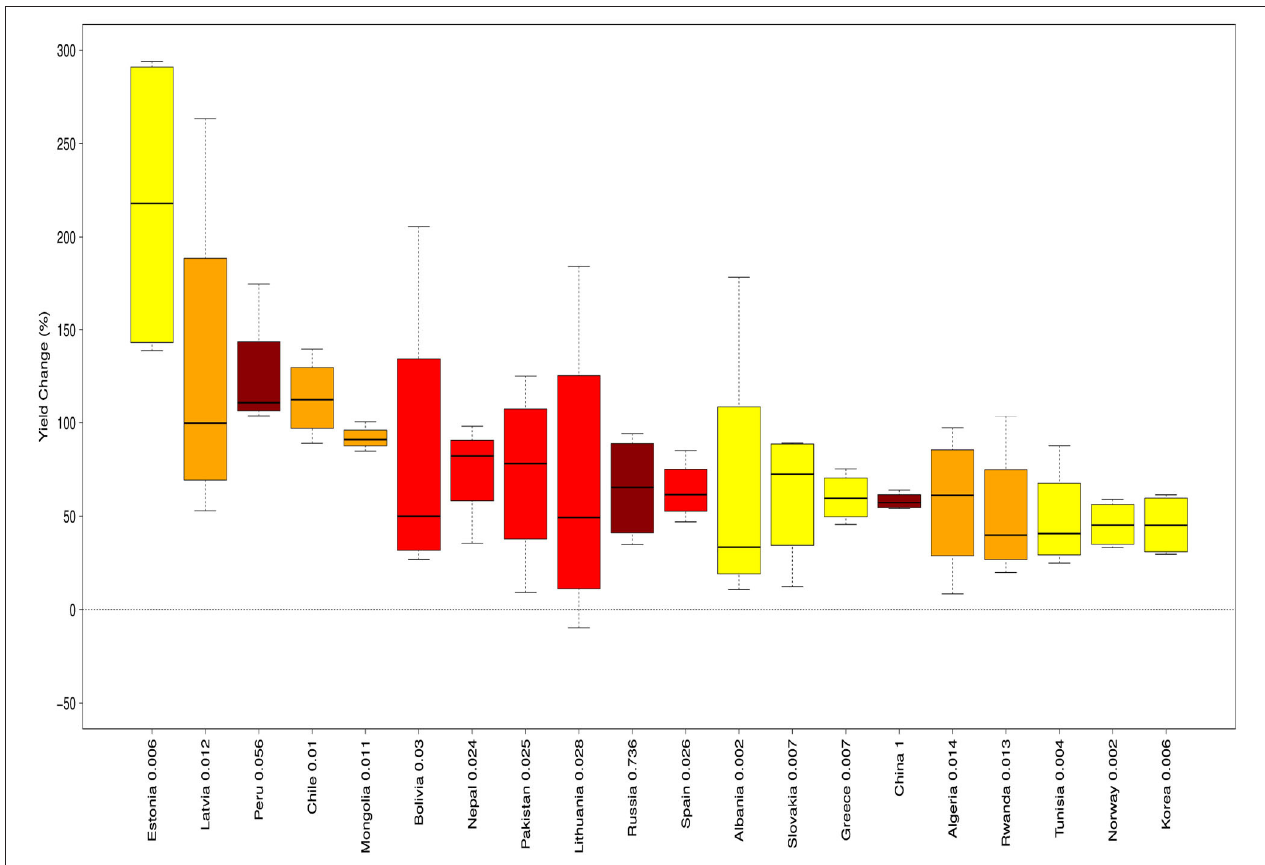
FIGURE 5 | Countries associated with the 20 largest increases in mean yields across climate models from the baseline to 2040–2060, with ranges across climate models, for the adaptation simulations. Boxplots show medians, interquartile ranges and the whiskers extend to 1.5 times the interquartile range. Dark red boxes show top 10 countries for growing area, light red = top 25, orange = top 50%, and yellow = bottom 50%. Numbers next to country names refer to the normalised growing area for each country, with a value of 1 indicating the largest growing area in one country, which is 4,394,406 ha in